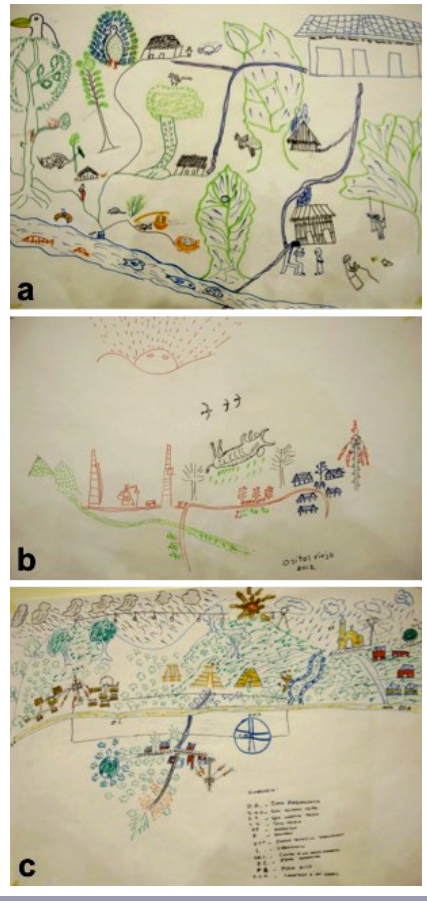
Fig. 3 . Vision of the council members of how the landscape used to be in the past (a), how it is today (b), and how they imagined their communities and the archaeological site would look 10 years into the future